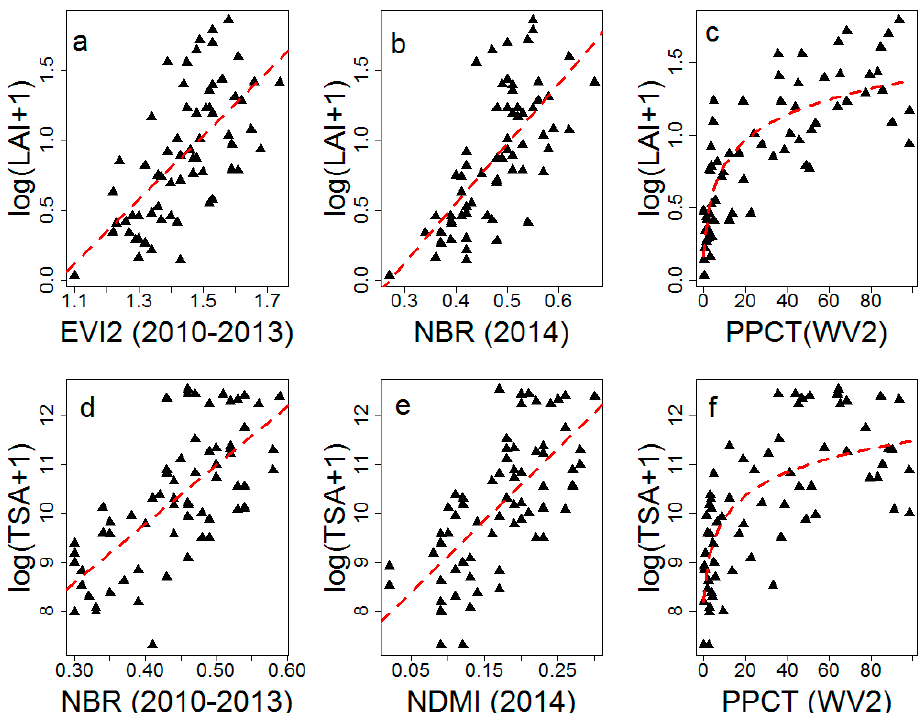
Figure 4. Scatter plots depict the best relationships (Table 4) between leaf area index (LAI) and two Landsat indices ( a , b ), and WroldView-2 case ( c ); and relationships between Tree sapling abundance (TSA) and two Landsat indices ( d , e ), and WroldView-2 case ( f ).